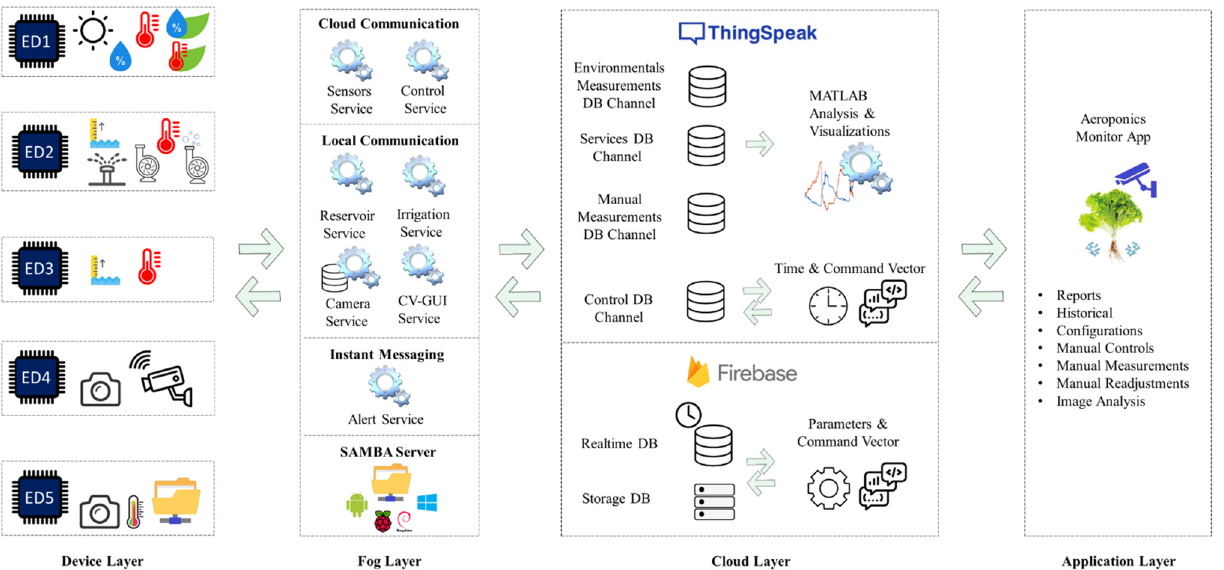
Figure 3. IoT architecture of the monitoring system.